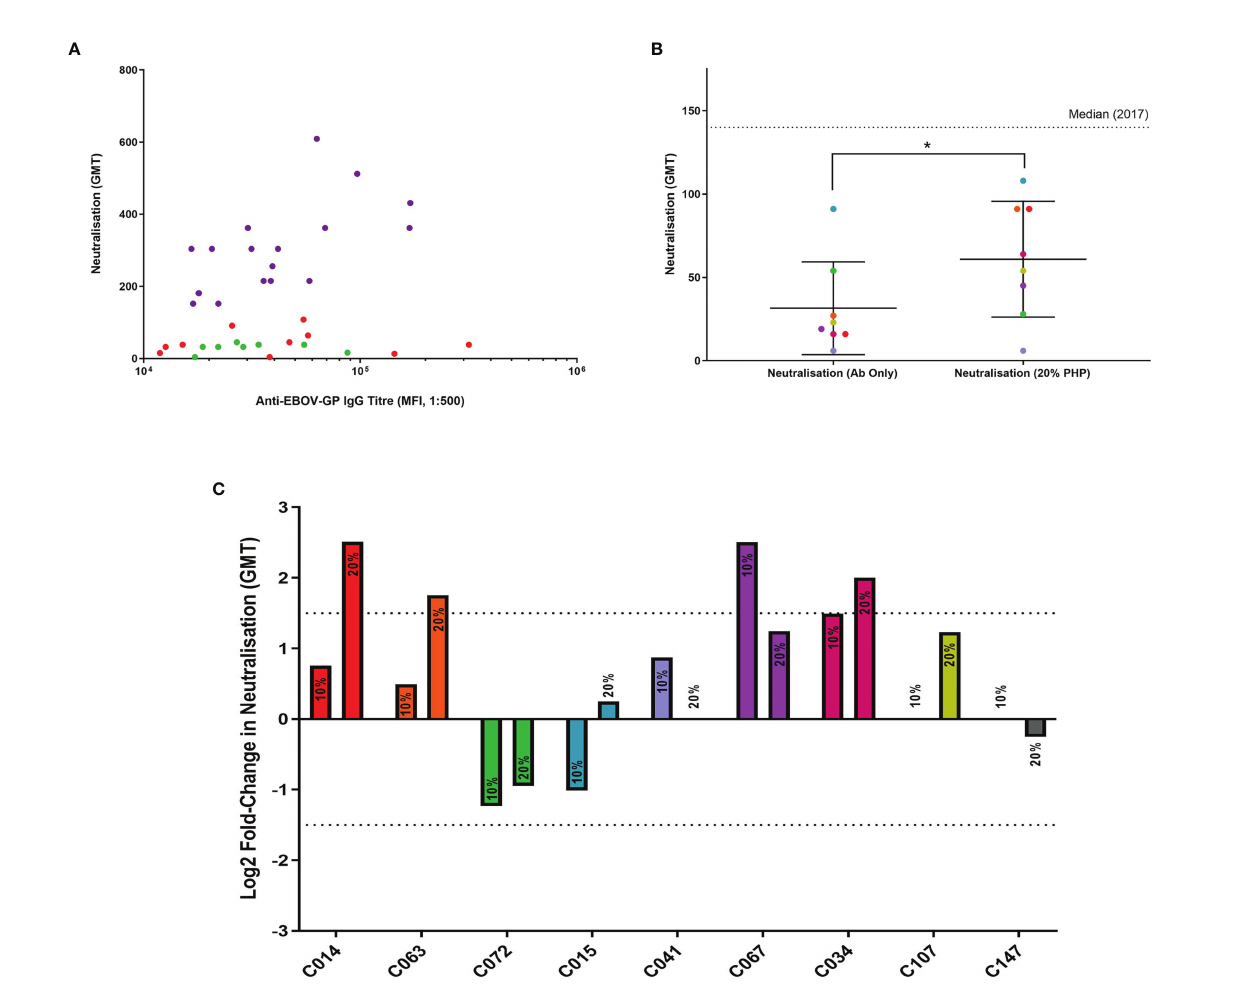
FIGURE 5 | Antibody neutralisation assays with wild-type EBOV, supplemented with PHP as a source of complement. (A) Eight samples from the LN cohort were selected for use in wild-type EBOV neutralisation assays (green dots). The remaining samples represent the LN cohort (red dots) and the N cohort (purple dots). All samples are illustrated using IgG titres determined in this study via fl ow cytometry and compared to historic 2017 neutralisation data. (B) Comparison of LN cohort neutralisation with or without 20% PHP, analysed using a one-tailed Wilcoxon signed-rank test (P = 0.031). (C) Comparison of individual samples analysed via a log2 fold-change with 10% and 20% PHP compared to antibody-only samples, with a negative cut-off below 1.5 (dotted line). * = signi fi cant (P <